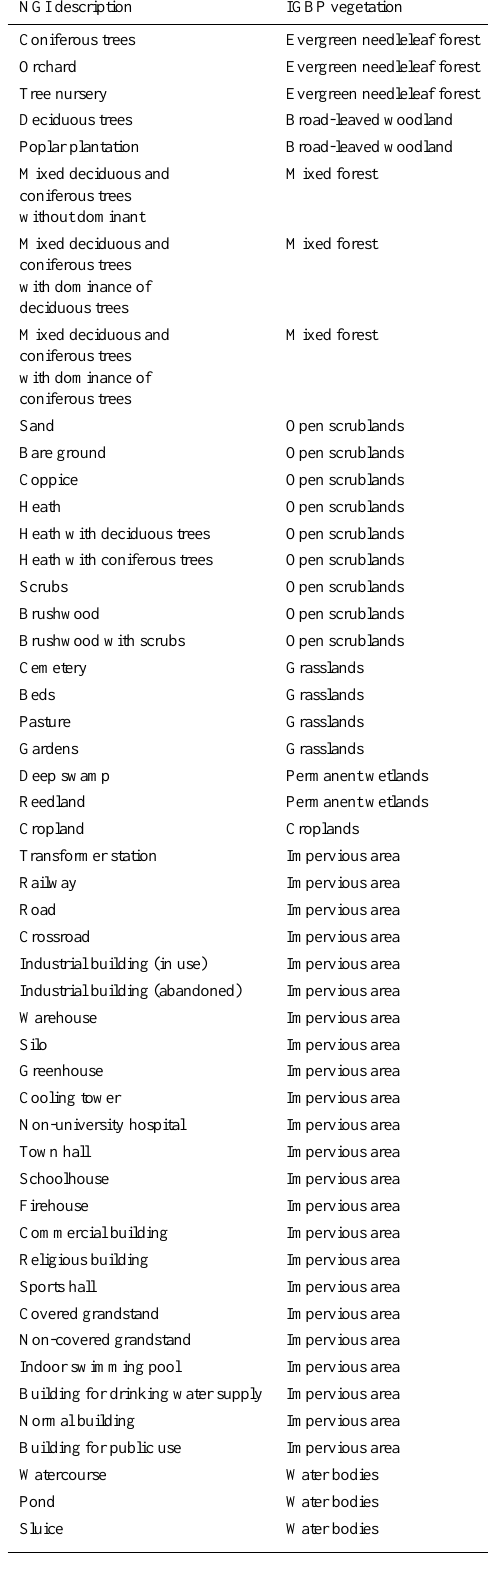
Table 1. Overview of the different land use classes used in the NGI map and the reclassification to 9